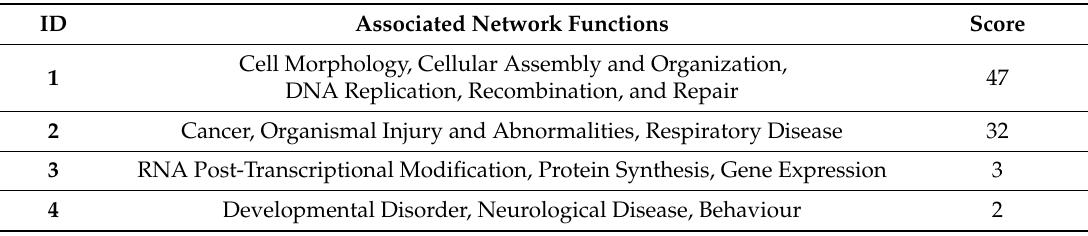
Table 4. Top Associated Networks for LAP1 interactors dataset.